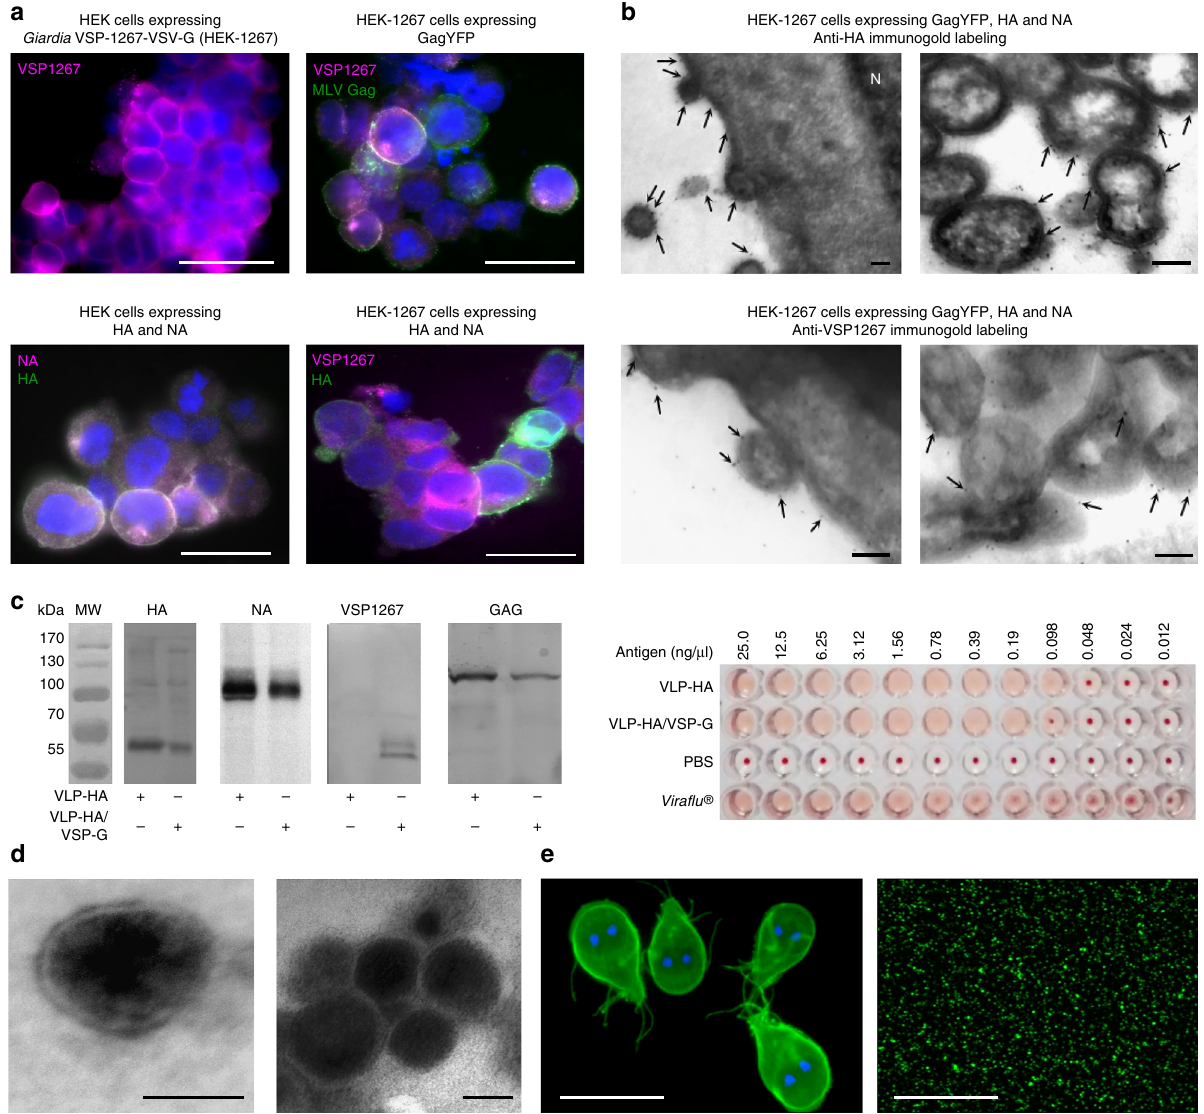
Fig. 3 VLP characterization. a Immuno fl uorescence microscopy of HEK cells used in VLPs production. The different DNA constructs used are indicated on top of each fi gure. In all immuno fl uorescence images, nuclei are labeled with DAPI (blue). The white signal represents colocalization. The bars represent 20 μ m. b Electron micrographs of 100 nm-thick cryosections showing VLPs budding from the surface of HEK-1267 cells. Five nanometer immunogold labeling of HA (top panels) and VSP1267 (bottom panels) indicates their localization in cells and VLPs membranes (arrows). N, nucleus. The bars represent 100 nm. c Western blotting and hemagglutination assays showing the correct assembly of VLPs. d Representative TEM negative staining of VLPs (VLP-HA on the left and VLP-HA/VSP1267-G on the right). The bars represent 100 nm. e Immuno fl uorescence images of VSPs on the surface of Giardia trophozoites (left) and of VSP-G on the surface of VLPs (right). In both cases, mAb 7F5-FITC anti-VSP1267 extracellular domain was used. VSPs are labeled in green and nuclei stained with DAPI in blue. The bars represent 25 μ m. Source data are provided as a Source Data fi responses, respectively. Vaccinated and control mice were infec- ted by the nasal route with a mouse adapted strain of live in fl u- enza A H5N1 virus 35 . VLP-HA given orally did not protect the Table 1 Analysis of the size distribution and concentration of mice from the virus challenge, whereas mice orally immunized VLPs by nanoparticle trace analysis (NTA) with VLP-HA/VSP1267-G were fully protected, indicating the presence of a highly ef fi cient humoral response in the respiratory Sample Size (nm) Concentration tract. Control animals receiving recombinant HA plus alum (particles ml – 1 ) intramuscularly were only partially protected (Fig. 6a), similar to Mean Mode s.d. the reported ef fi cacy of the current human vaccines 22 . Challenged mice were monitored daily for disease signs (ruf fl ed fur, dyspnea, lethargy) and body weight changes for 2 weeks (Fig. 6b). No signi fi cant body weight loss or clinical signs of infection were observed in non-challenged mice or in mice